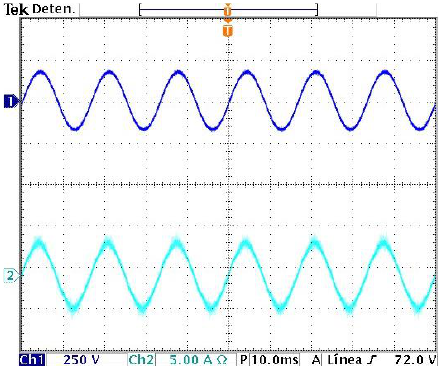
Figure 15. Steady-state waveforms when the PV injects energy. From top to bottom: node voltage and injected current.